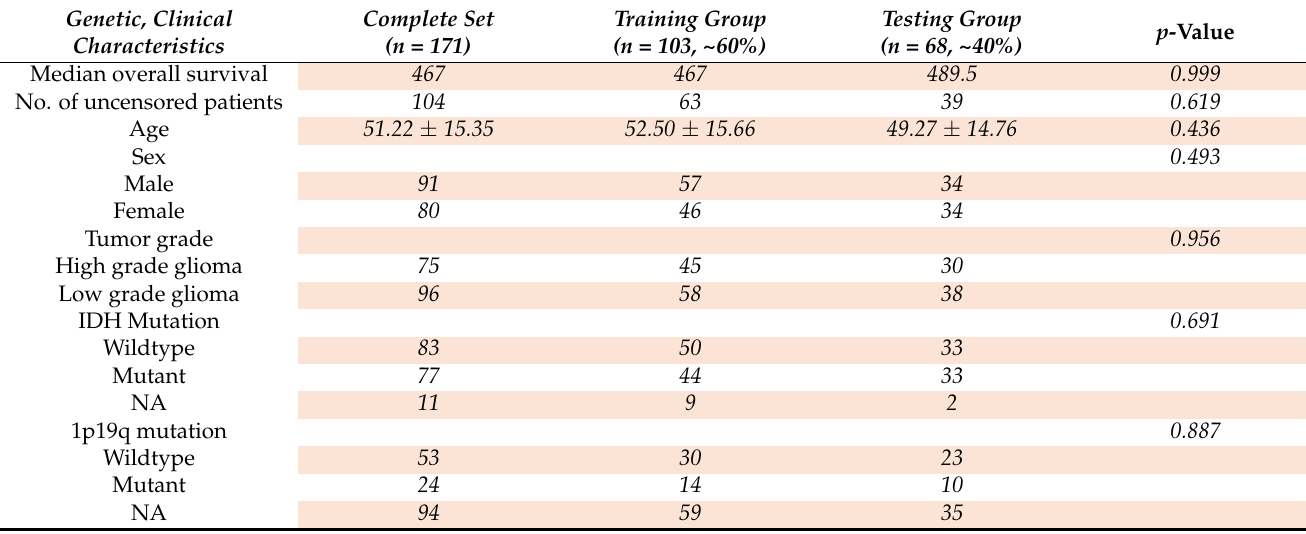
Table 1. Glioma patients’